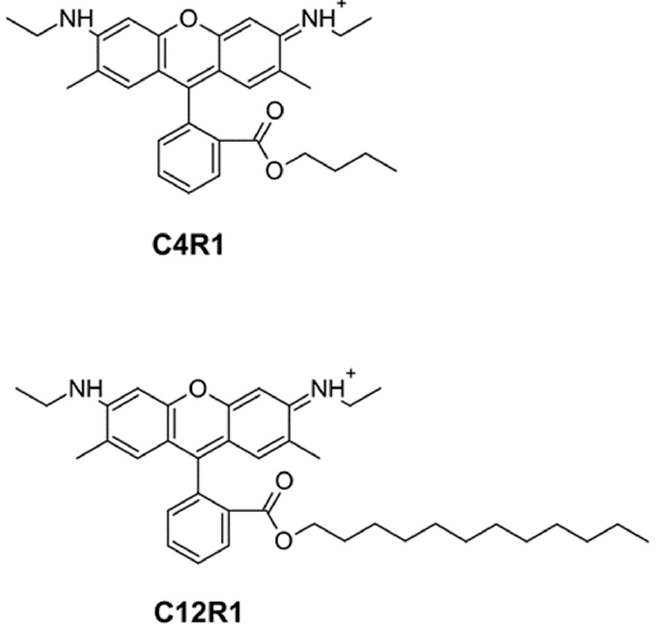
Figure 1. Chemical structure of C4R1 (butyl ester of rhodamine 19) and C12R1 (dodecyl ester of rhodamine 19).